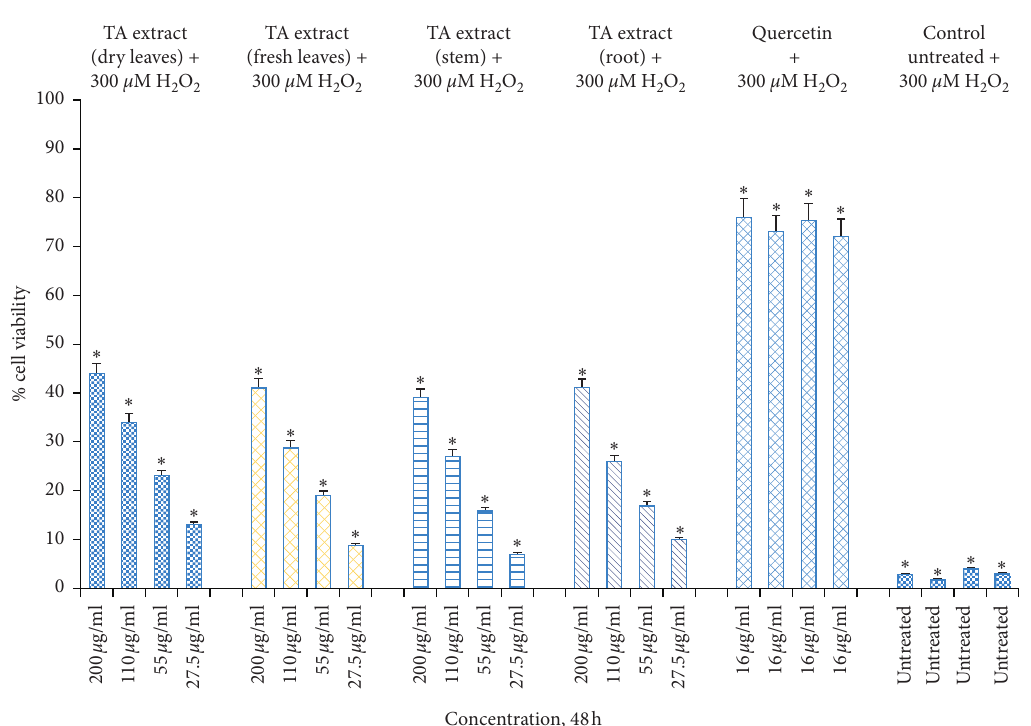
Figure 7: Cell viability determined by MTT assay. Hs27 skin fibroblasts were seeded at a density of 10,000 cells/well in 96-well plates and allowed to incubate overnight to attach to the surface. Next day, treat the cells with TA extracts (fresh and dry leaf, stem, and root extracts) for 48h along with quercetin as a positive control (16 μ g/mL) and control as untreated. After the completion of treatment, expose the pretreated cells with 300 μ M of H ₂ O ₂ for 1h. Data shown as mean ± SEM; n � 3, ∗ p < 0 . 05.